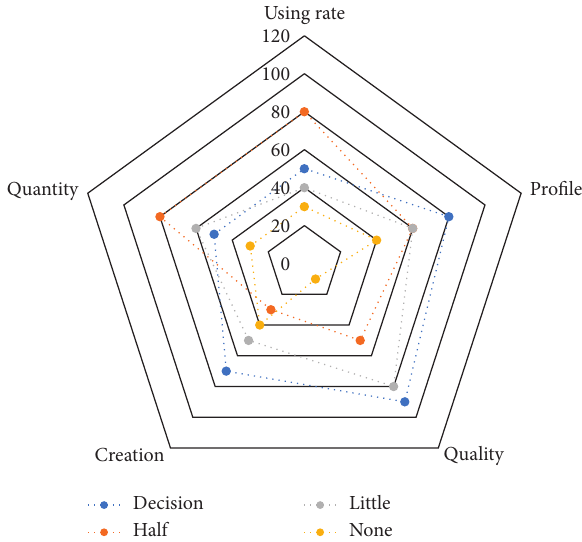
Figure 7: The difference between the decision result and the nondecision tree mining